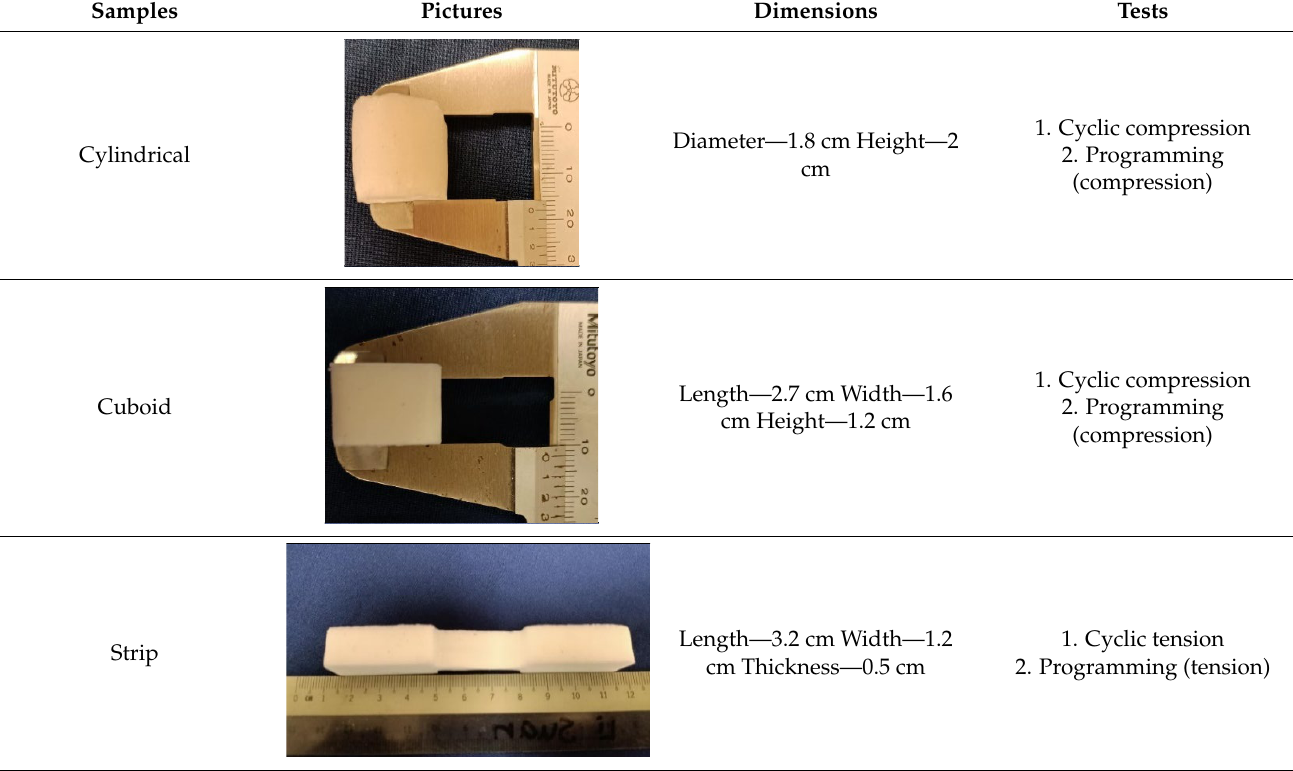
Table 1. Samples prepared.